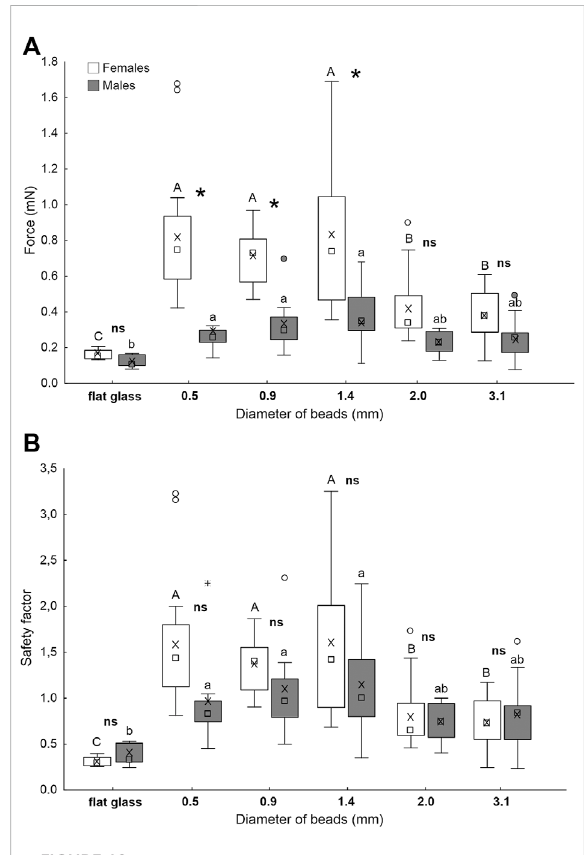
FIGURE 9 Friction force (A) andsafetyfactor(theforcedivided byinsect weight) (B) of A. bifasciatus females and males on hydrophilic and hydrophobic glass. Boxplots show the interquartile range and the medians,whiskersindicatethe1.5×interquartilerangeand “ ° ” shows outliers. Boxplots with different upper case letters and lower case letters, respectively, are signi fi cantly different at p < 0.05. In the comparison between females and males, the asterisk (*) means signi fi cant difference at p < 0.05 and ns means not signi fi cantly different (Tukey unequal N HSD post hoc test, Repeated measures one-way ANOVA).